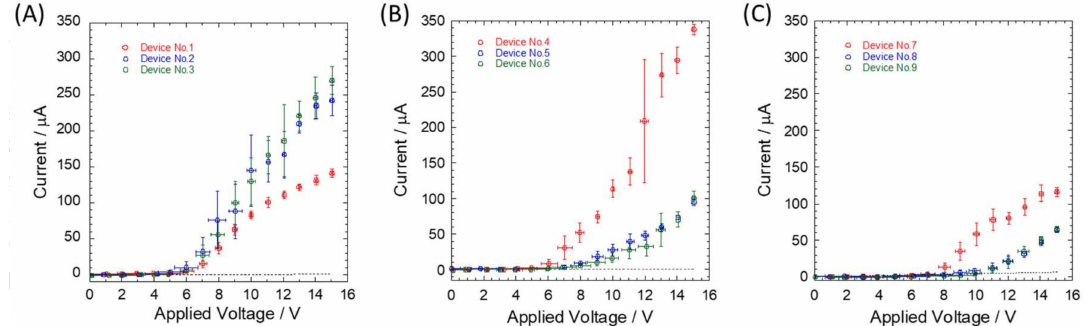
Figure 3. Monitored time-average currents were plotted as a function of the applied voltage. ( A ) NO, ( B ) 100 nm, and ( C ) 250 nm thick oxide layers on the silicon microchannels were filled with 5 × TBE. Currents were measured in nine distinct devices, which are depicted in red, blue, and green circles, respectively. Dotted lines show theoretical currents under the assumption that no dielectric breakdown occurs and an electrical current pass through a microchannel.